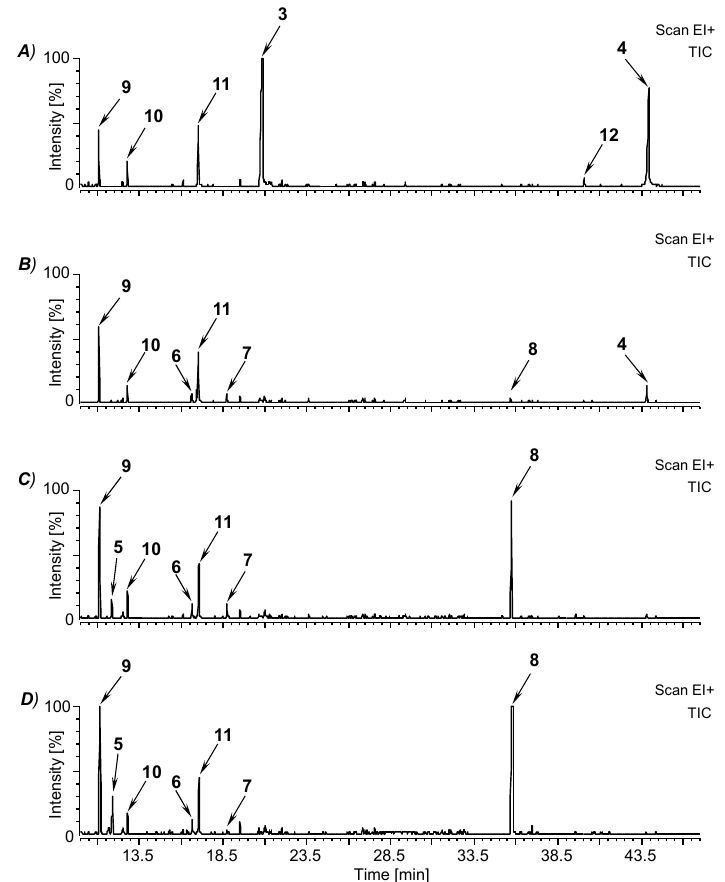
Figure 2. Sections of GC-MS profiles (EI) showing metabolites of M. perennis root extracts. ( A ) Before ( t = 0 days); ( B ) after 1 day ( C ); after 6 days and ( D ) after 14 days of fermentation with Pediococcus sp. (PP1). For compound assignment, see Table 2.